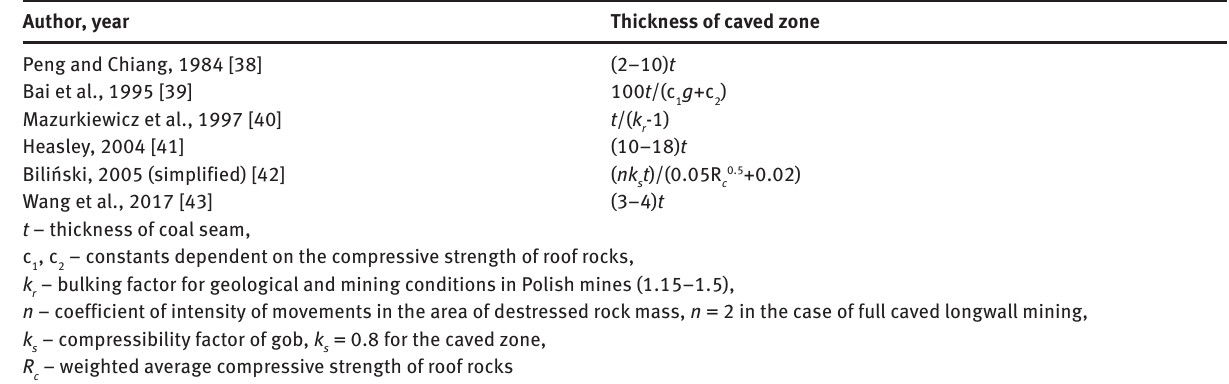
Table 3: Hypotheses for calculating thickness of the caved